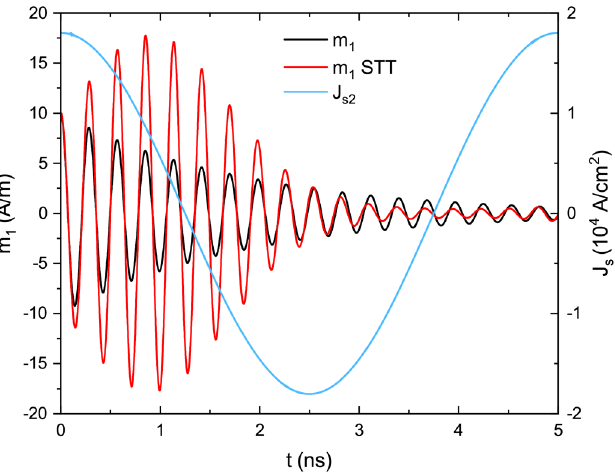
Figure 3. The time-dependence of the magnetization component m 1 (red line) and spin current J s 2 (blue line) in Co in the MEC subjected to the ac voltage; black line shows m 1 dynamics in the absence of ac voltage.